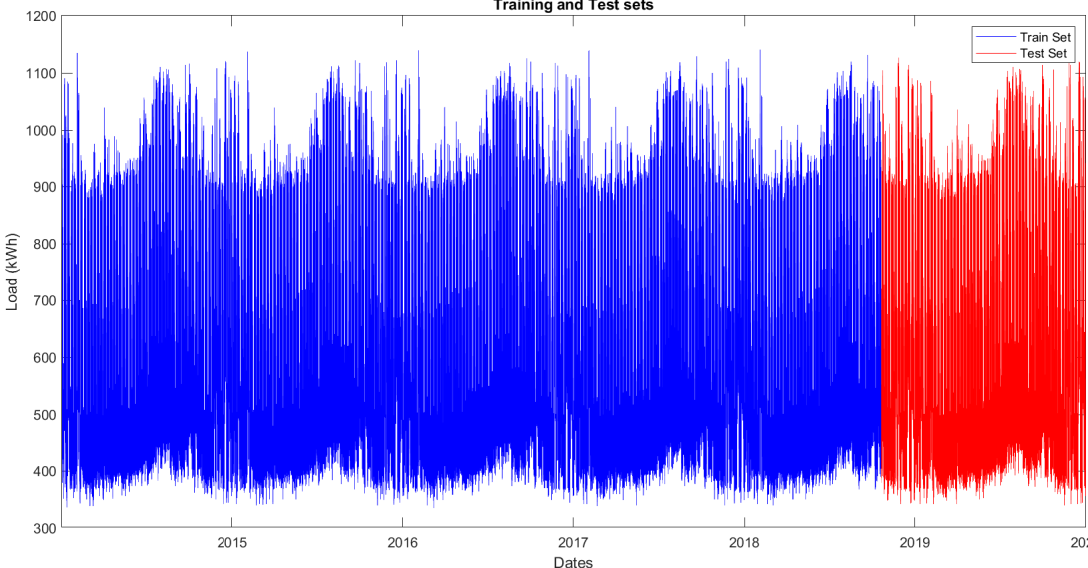
Figure 8. The train and test sets.